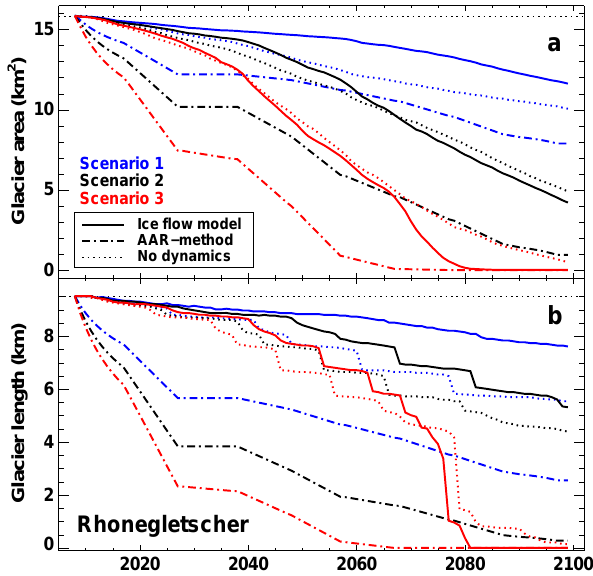
Fig. 14. Comparison of simple alternative approaches for calculating future glacier change with the ice flow model. (a) Glacier area, and (b) length (Rhonegletscher).